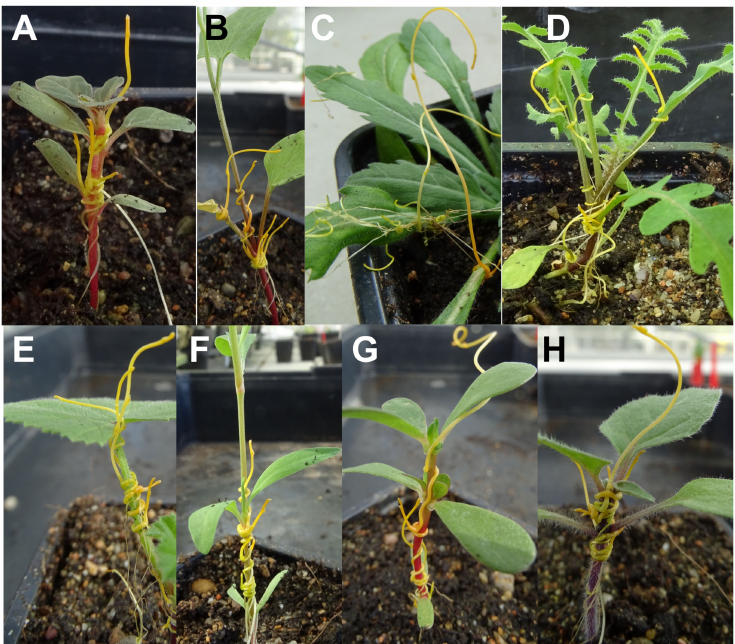
Figure 4. Illustrative photographs of Cuscuta campestris posthaustorial growth at the site of attachment on ( A ) Amaranthus albus ; ( B ) Convolvulus arvensis ; ( C ) Conyza bonariensis ; ( D ) Diplotaxis virgata ; ( E ) Malva sylvestris ; ( F ) Polygonum aviculare ; ( G ) Portulaca oleracea ; ( H ) Solanum nigrum